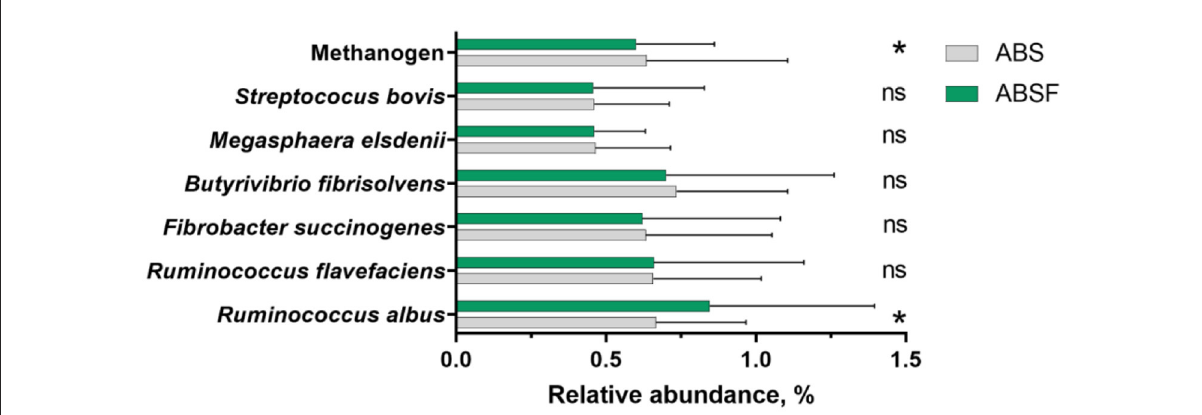
FIGURE2 The relative abundances of selected microbial rumen bacteria in goats fed a total mixed ration supplemented with anthocyanin-rich black cane silage (ABS) or anthocyanin-rich black cane silage treated with ferrous sulfate heptahydrate (ABSF). The values are means, with horizontal bars representing standard errors. The values were different ( * P < 0.05; ns P > 0.05).